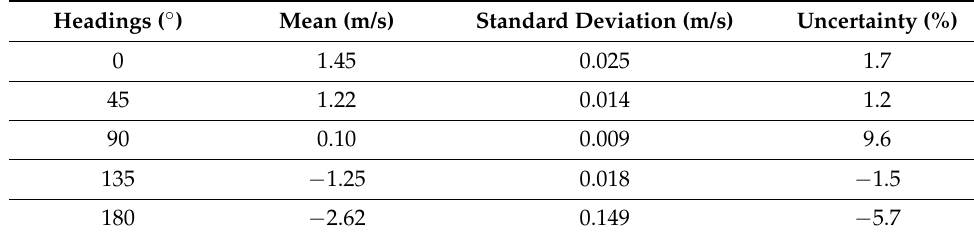
Figure 3. Comparison of four wind tunnel tests of moss-type LNGC. Schemes follow the same formatting. ( a ) Measured x-force coefficients; and ( b ) trend lines. Table 1. Experimental uncertainty analysis for moss-type LNGC.